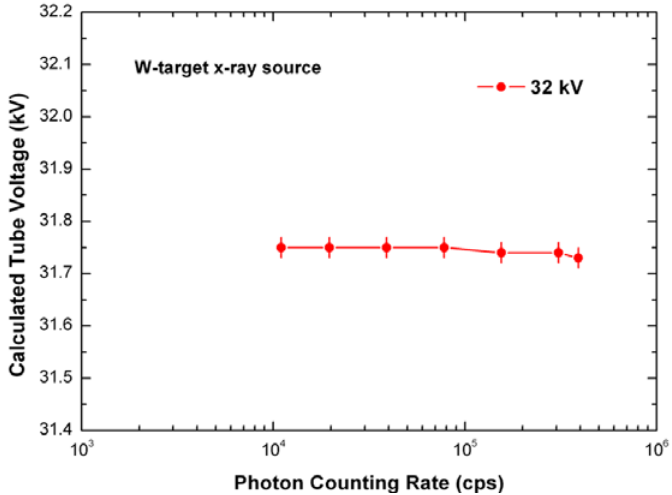
Figure 5. Calculated tube voltage values vs . photon counting rate (W anode). Relative errors less than 0 . 22%, with a confidence level of